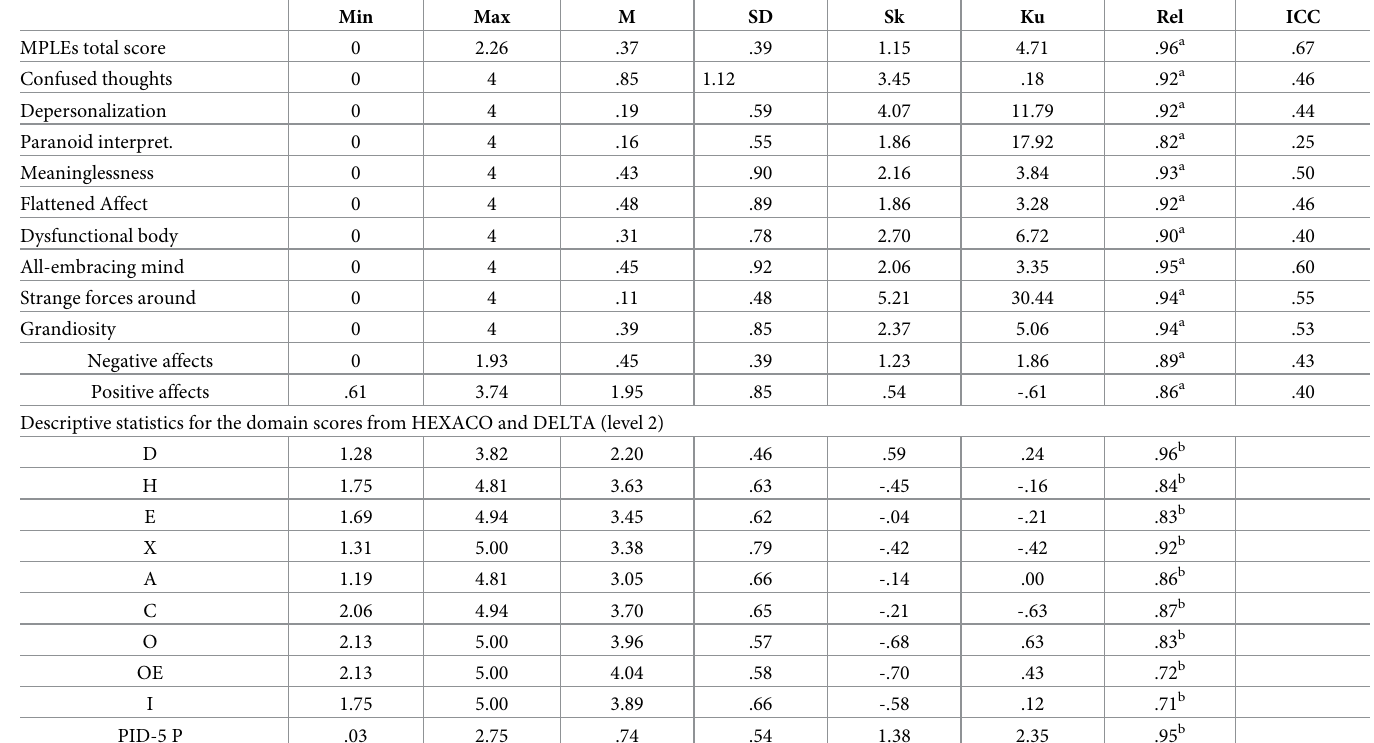
Table 1. Descriptive statistics for the variables measured at level 1 (14 measurements aggregated across a subject, N = 180, 2508